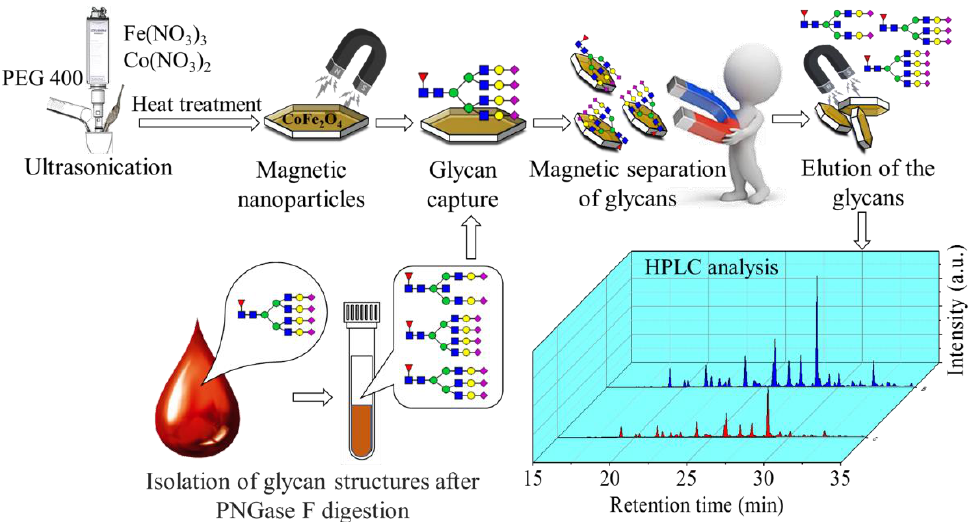
Figure 1. Scheme of the preparation of the ferrite nanoparticles, and their application in magnetic glycan separation method.